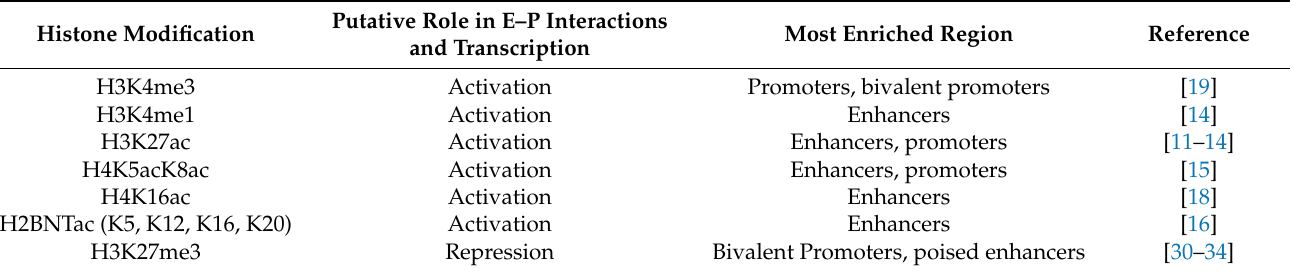
Table 1. Summary of histone modifications and their putative role in enhancer–promoter (E–P) interactions and